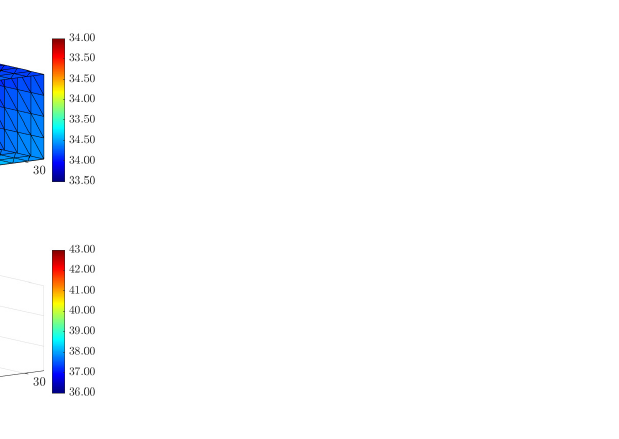
Figure A4. Temperature ( θ [ ◦ C]) distribution on the boundary of the microelectronic packaging for P = 0.15